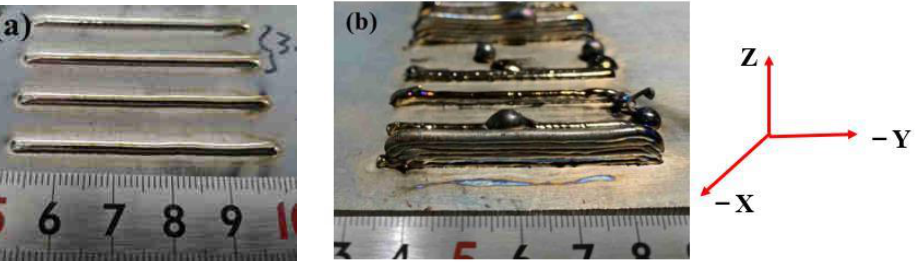
Figure 3. Single-bead ( a ) and single-pass seven-layer thin-wall ( b ) samples, along with the